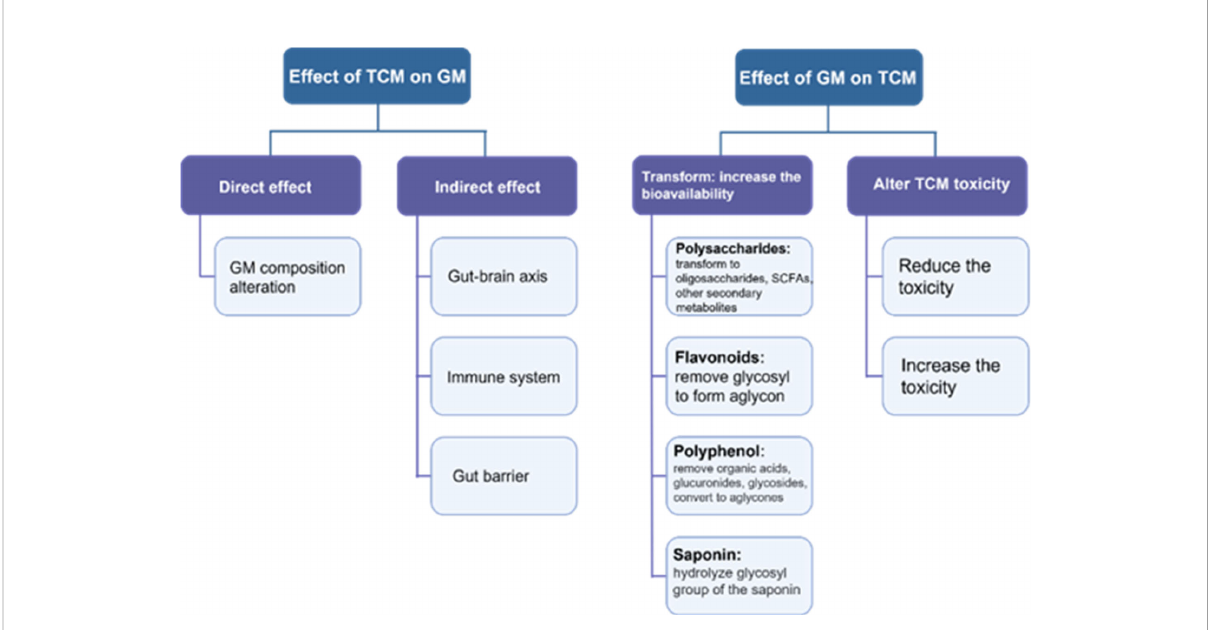
FIGURE 3 A schematic diagram displaying the interaction between TCM and